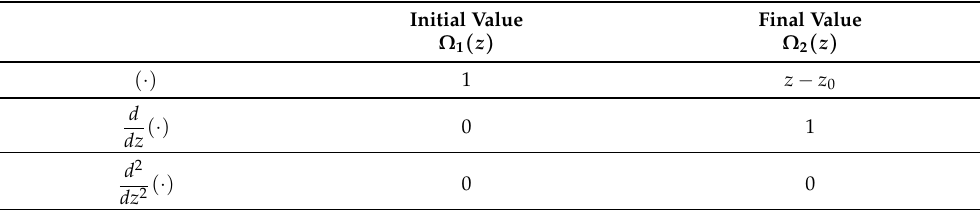
Table A4. Switching functions for a two constraints constrained expression, with one constraint on f and one on f (cid:48) , defined on domain of z ∈ [ z 0 , z f ] .